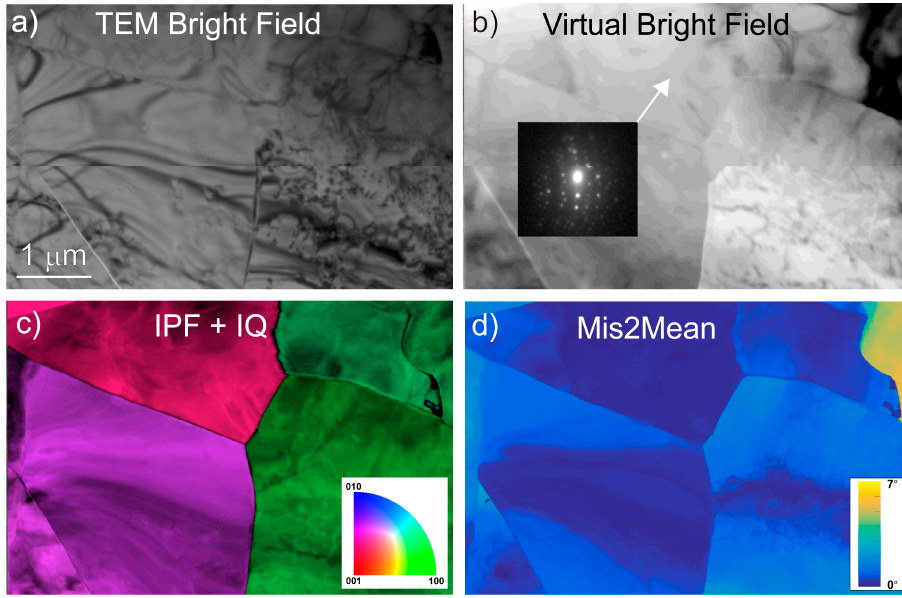
Figure 1. M642. ( a ) Conventional multibeam transmission electron microscopy (TEM) bright field. ( b ) Virtual bright field of the same area reconstructed from the intensity of the transmitted beams of the scanning precession electron diffraction (SPED) dataset (an example of a diffraction pattern acquired is presented). ( c ) Inverse pole figure (IPF) corresponding to the horizontal direction superimposed with the quality of indexation (IQ) (Equation (1)); color code inserted ( Pnma ). ( d ) Mis2Mean map, up to 7 ◦